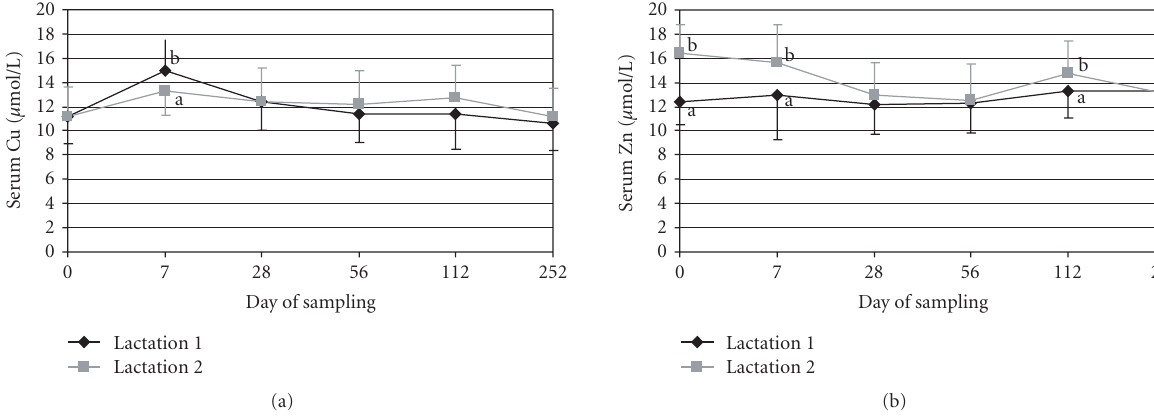
Figure 2: Copper (a) and zinc concentration (b) in blood serum ( μ mol/L) in the di ff erent lactations (1 and 2); a < b, P < . 05.